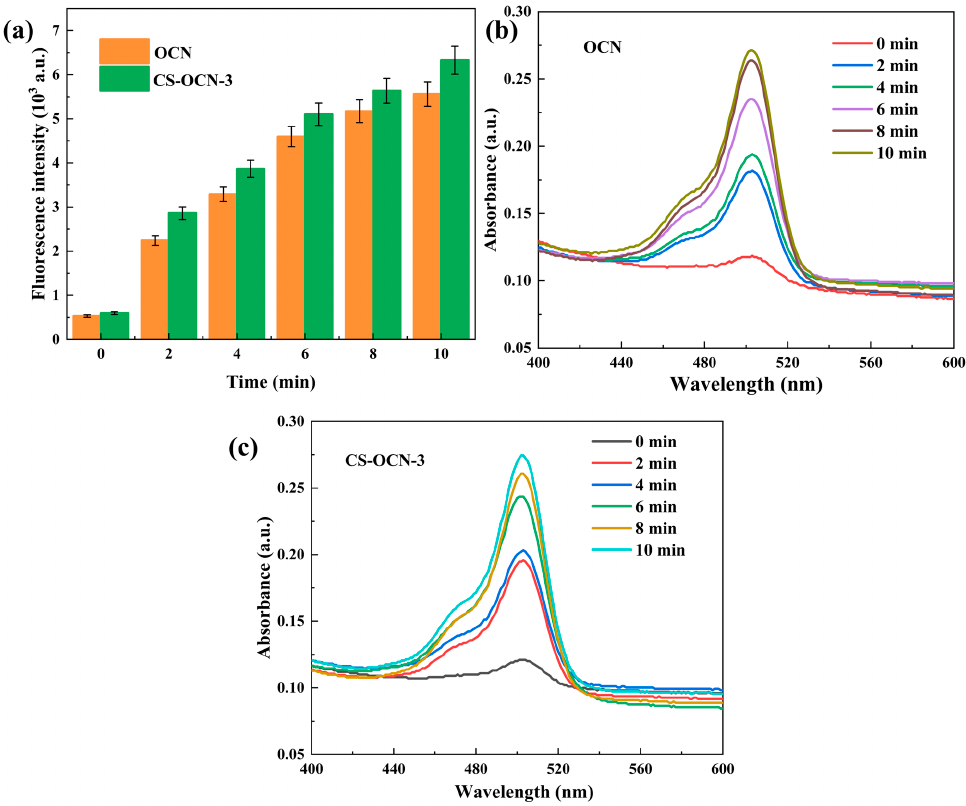
Figure 8. ( a ) Fluorescence intensity of H2DCFDA ( λ em = 485 nm) with the presence of OCN and CS-OCN-3 with 10 min light irradiation. Absorption spectra of H2DCFDA with the presence of ( b ) OCN and ( c ) CS-OCN-3 with 10 min light irradiation. Light irradiation significantly increased the production of ROS.